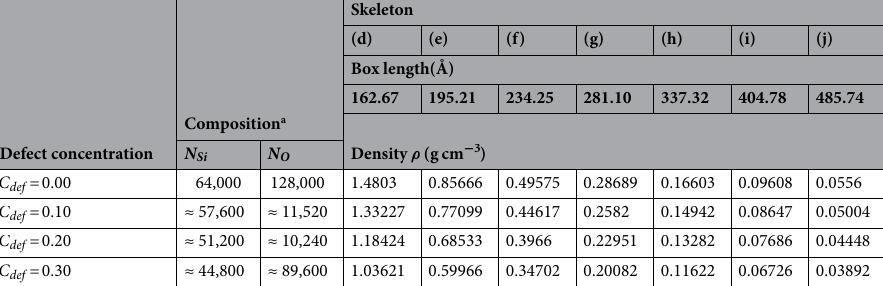
Table 4. The simulation box length and compositions of the skeletons d – j with different defect concentration C def . a N Si : the number of silicon atoms; N O : the number of oxygen atoms.